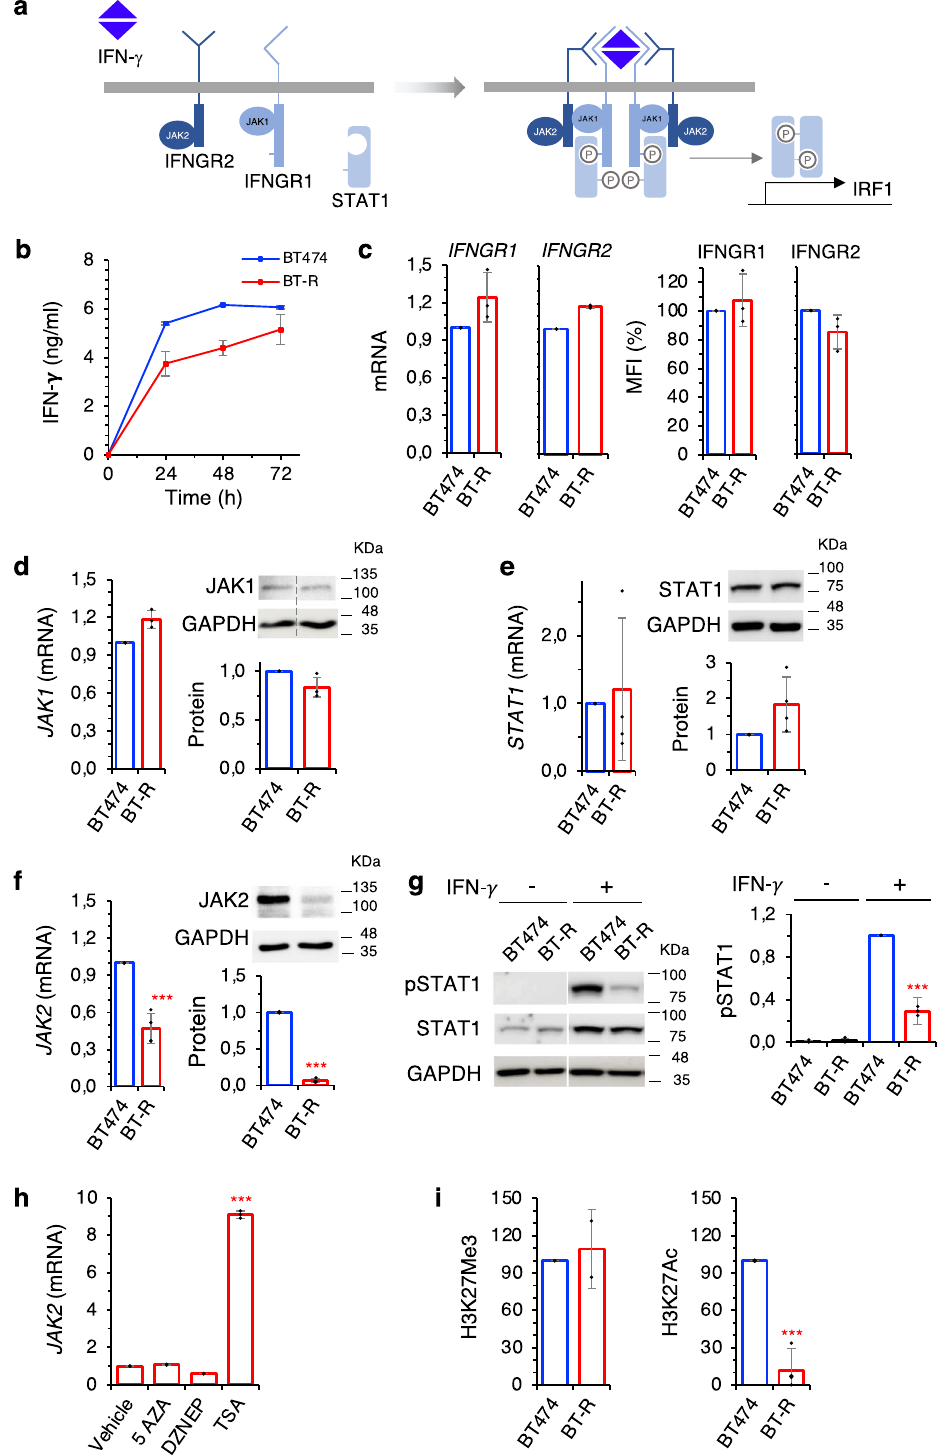
Fig. 4 Components of the IFN- γ signaling pathway in resistant cells. a Schematic showing the IFN- γ signaling pathway. b The levels of IFN- γ in the media conditioned by cocultures with BT474 or resistant BT-R in the presence of HER2-TCB was determined by ELISA. c The levels of Interferon-gamma receptors 1 and 2, normalized to BT474, were determined by quantitative real-time PCR (left) or fl ow cytometry with speci fi c antibodies (right). d – f Levels of JAK1, STAT1, and JAK2 (mRNA and protein), normalized to BT474, as determined by quantitative real-time PCR (left) or Western blot (right). g Levels of phosphoSTAT1 in parental and resistant cells were determined by Western Blot. Results were normalized to treated BT474 cells. h BT-R cells were treated with indicated compounds for 48 h. Then, the levels of the mRNA encoding JAK2 were determined by RT-PCR and normalized to the levels in cells treated with vehicle. i Levels of H3K27Me3 and H3K27Ac histone marks in the promoter of JAK2 in BT474 and BT-R cells as measured by ChIP followed by quantitative real-time PCR. Results were normalized to the levels of an IgG control antibody in each sample, and then normalized to the levels in BT474 cells. *** p < 0.001, two-tailed t test. Data are presented as mean ± SD of two ( b , i left), three ( c , d , h , i right) or four ( e – g ) independent experiments. Source data are provided as a Source Data fi